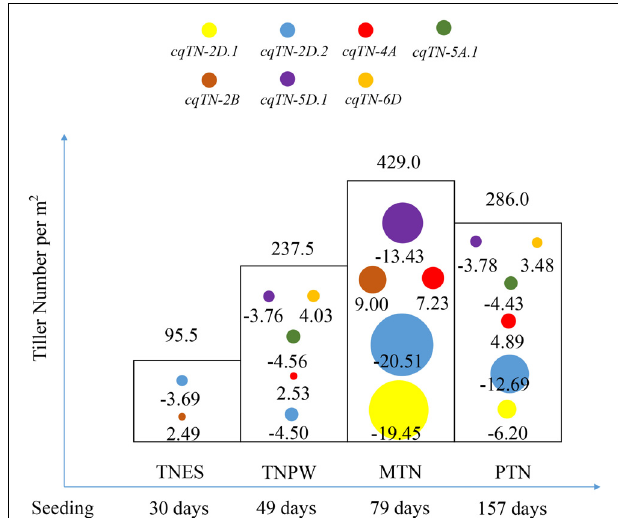
FIGURE 2 | The dynamic QTL analysis for TN across four growth stages. Circles with different colors represent different QTL identified by combined QTL analysis. The value below each circle represents the additive effect of corresponding QTL. The value at the top of each column represents the average tiller number across the RIL population between 2 years. TNES, TNPW, MTN, and PTN represent the different growth stages of